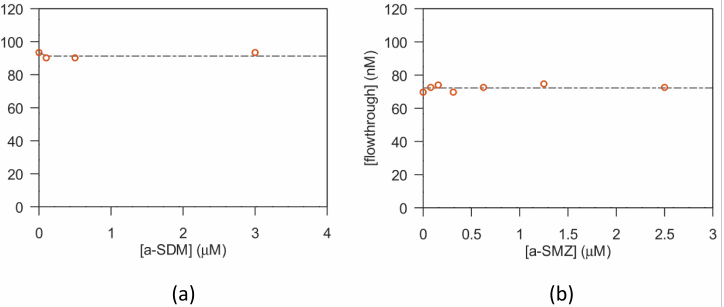
Figure 4. Filtration test of sulfonamides. ( a ) Data obtained with sulfadimethoxine and a-SDM aptamer. ( b ) Data obtained with sulfamethazine and a-SMZ aptamer. Y axes show the concentration of antibiotic present in the filter flow